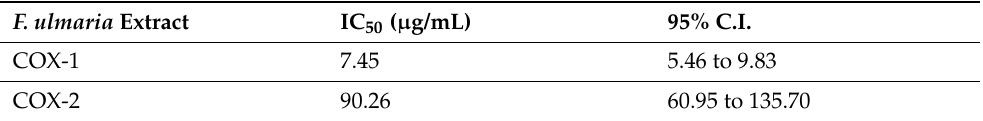
Figure 9. The effect of the F. ulmaria extract and the mix (20 µ M of gallic acid and salicylic acid, 6 µ M of quercetin and 4 µ M of syringic acid) on COX-2 enzyme inhibition. Celecoxib (2.5 µ M), in yellow, served as positive control. The graph depicts compiled data of three independent experiments (mean ± SD). p -values are expressed as *** p < 0.0001 compared to control. Table 1. IC 50 of F. ulmaria extract on COX activity.